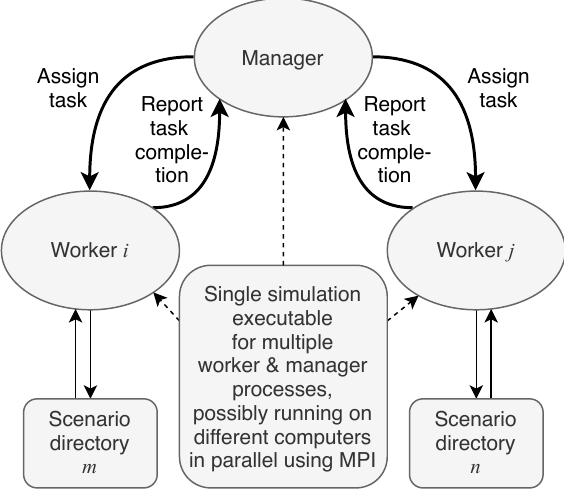
Figure 3. Manager-worker